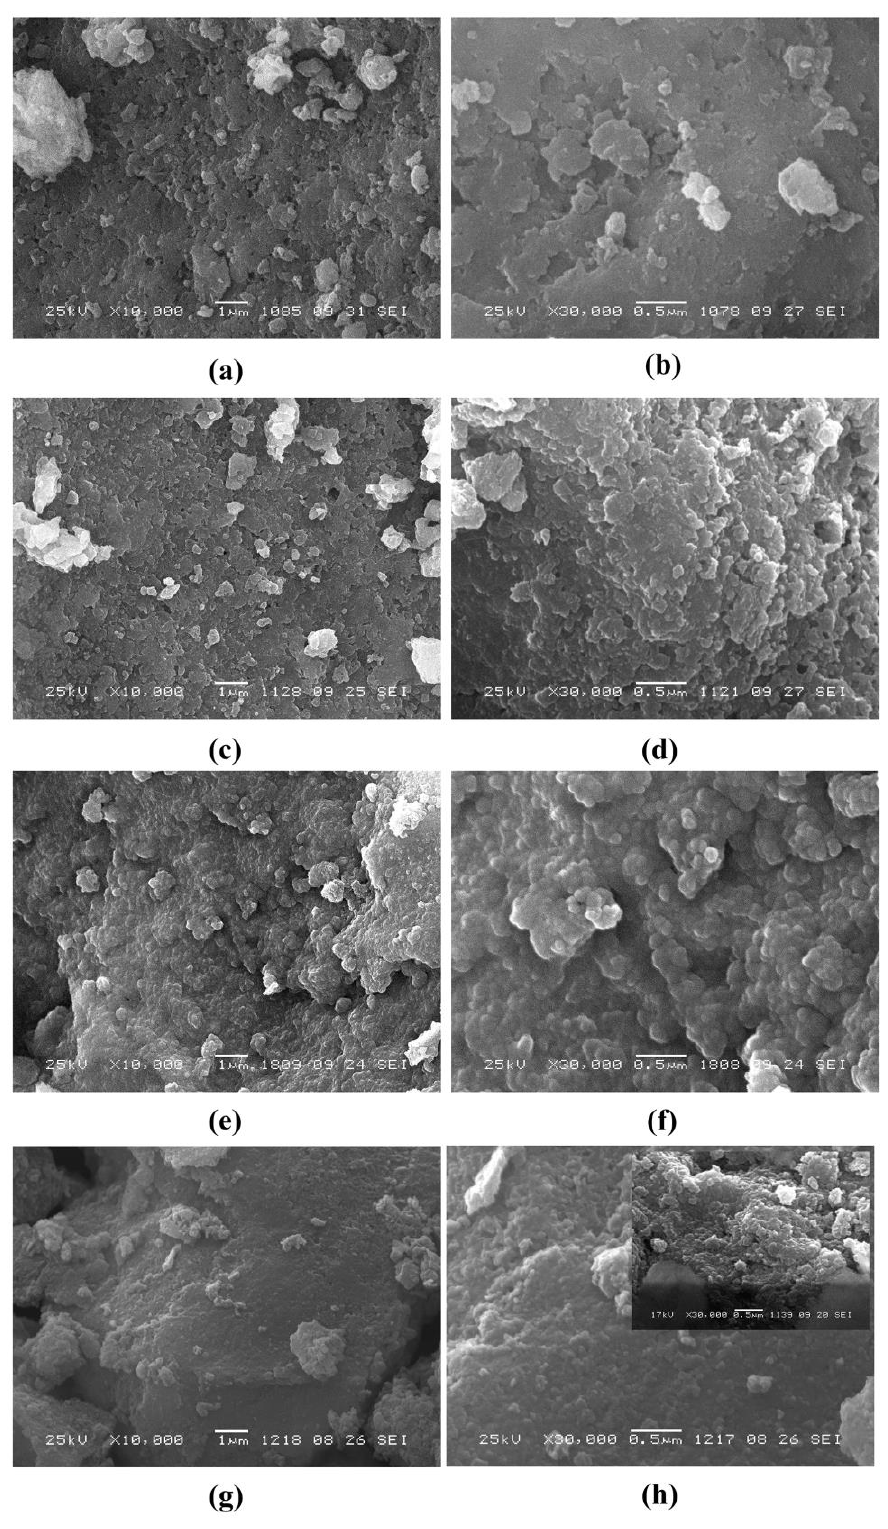
Figure 2. SEM images of the samples: ( a , b ) NiAl-3, ( c , d ) NiAl-4, 3, ( e , f ) 0.5NiMgAl-4, 4, ( g , h ) 0.3NiM- gAl-4.